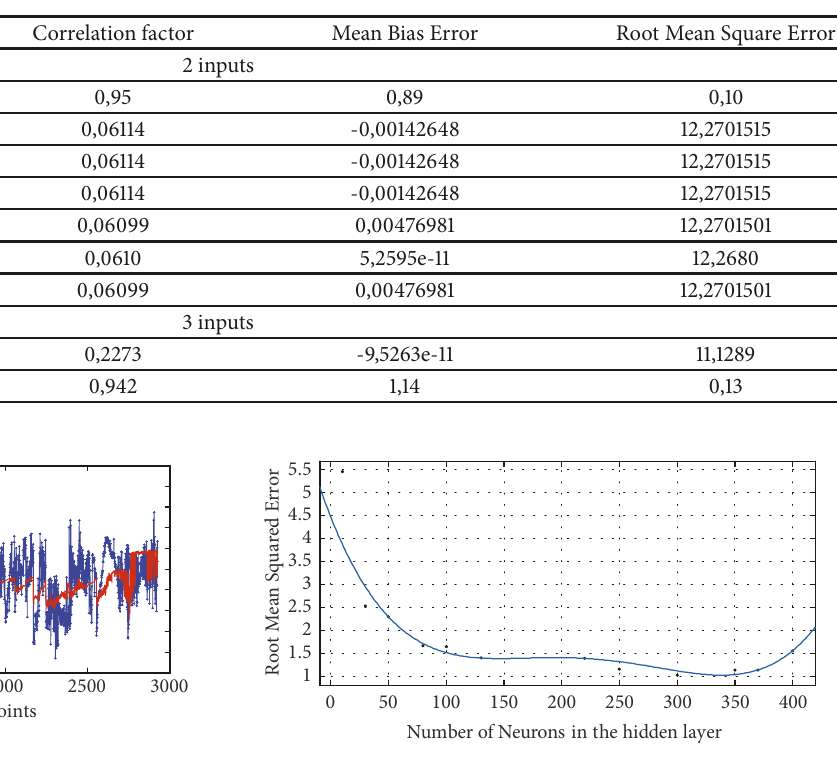
Figure 13: Root Mean Square Error (RMSE) versus number of neurons in the hidden layer (NNHL) for three inputs. Table 2: Errors against the number of iterations and neurons in the hidden layer for 2